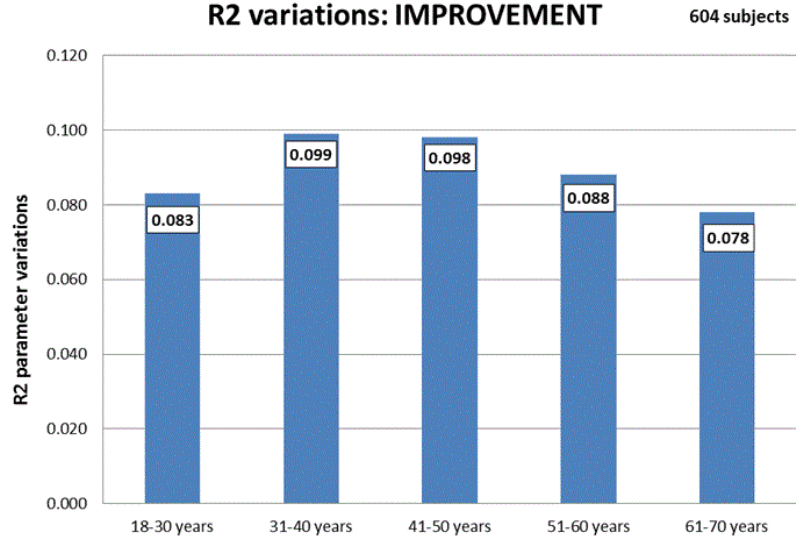
Figure 4. Improvements in skin elasticity values at the end of a cosmetic treatment as a function of the age group. Statistical comparison among the age groups: p > 0.05